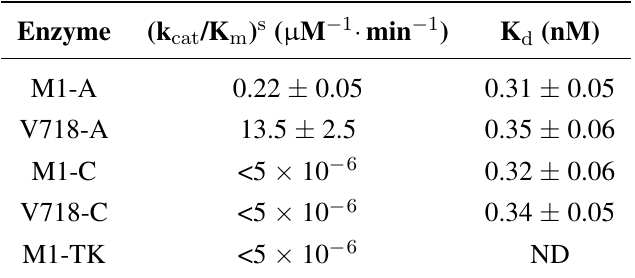
Table 1. Kinetic parameters [(k with substrate